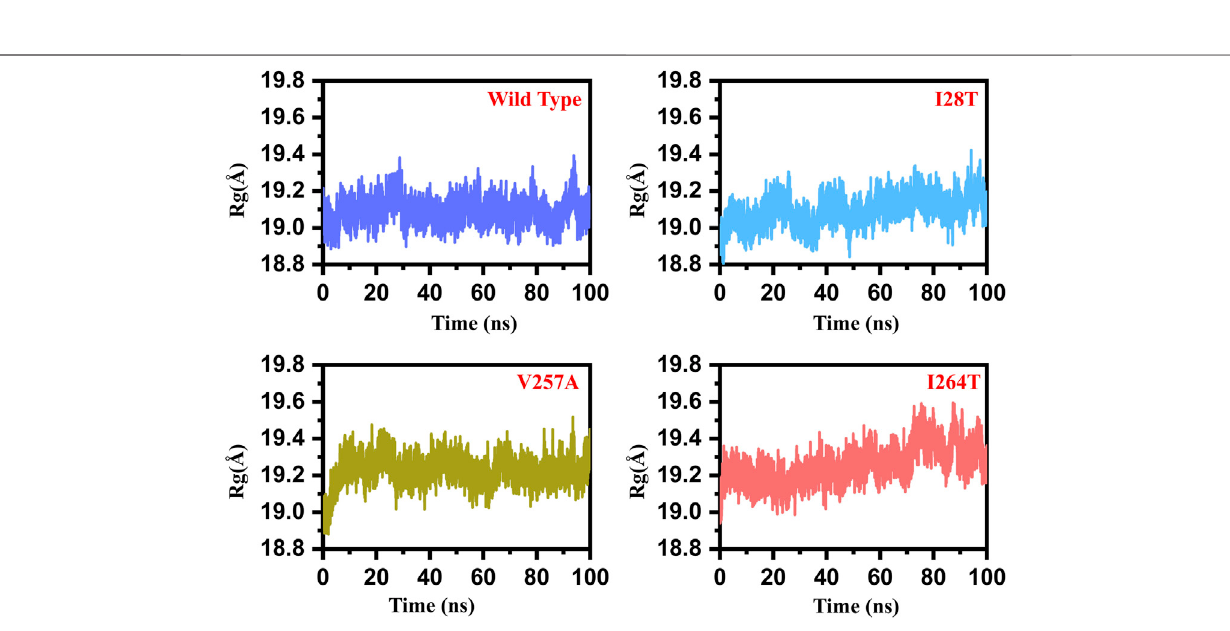
Frontiers in Molecular Biosciences |